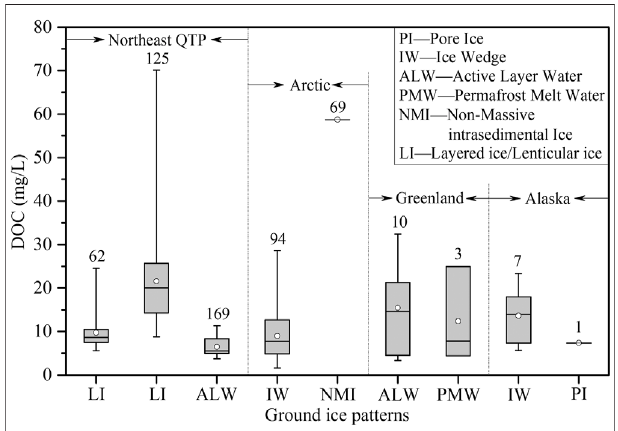
FIGURE6| BoxplotofDOCconcentrationsindifferentground-icetypes in northern hemisphere permafrost regions. Plot shows minimum, maximum, and median values, and the sample sizes in each